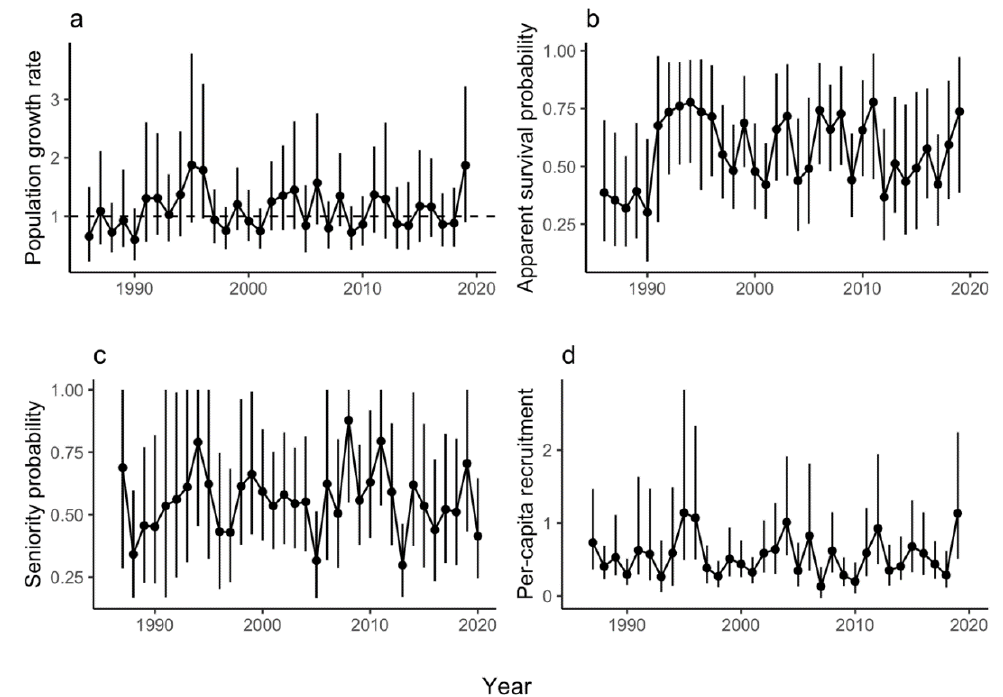
Figure 4. Matthews Pond: Annual estimates and 95% credible intervals (CI) of ( a ) population growth rate (ρ) where the horizontal dashed line represents a stable population (i.e., growth rate of one), ( b ) mean survival probability (φ), ( c ) mean seniority probability (γ), and ( d ) per-capita recruitment.